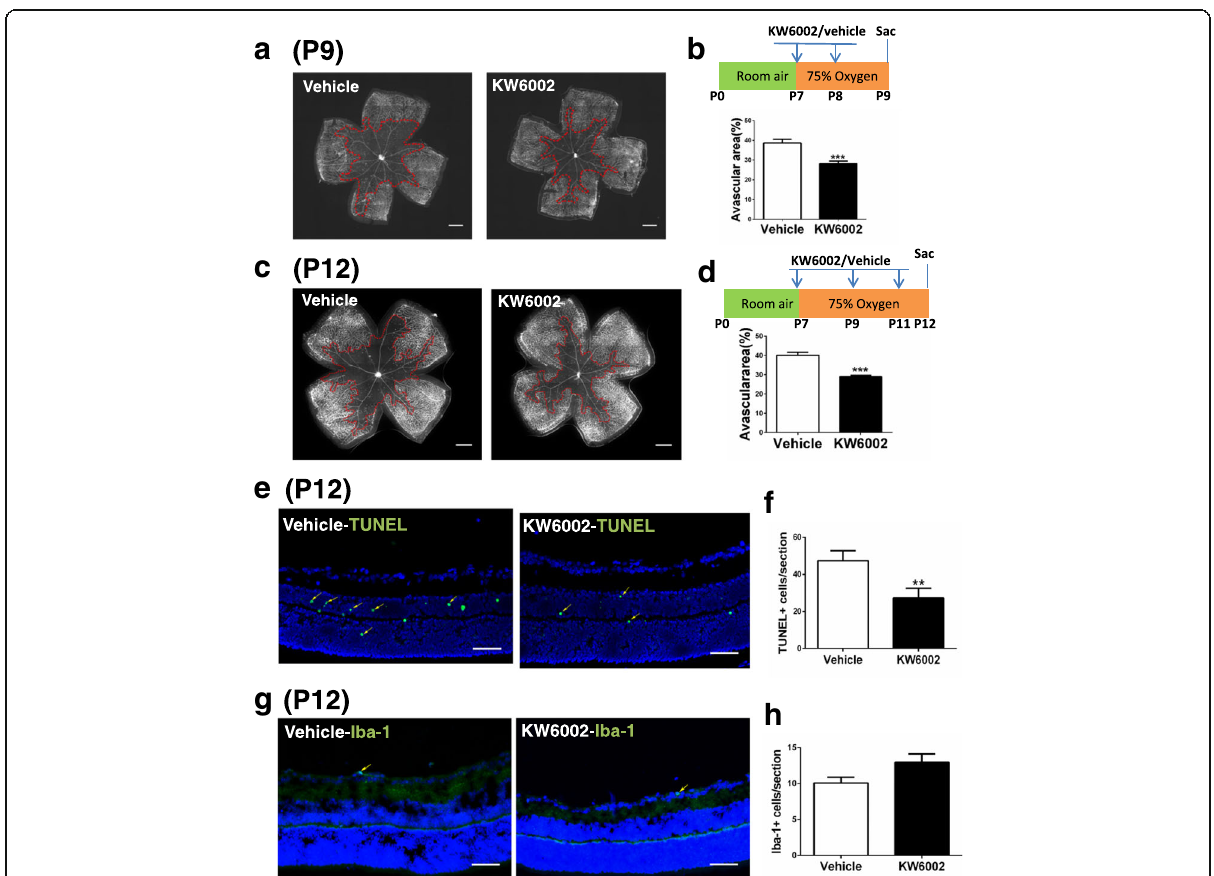
Fig. 5 KW6002 treatment reduced hyperoxia-induced retinal vascular regression at P9 and P12 and cellular apoptosis at P12, does not affect the activation of microglia. Whole-mount retinas ( a , c ) or retinal cross-section ( e , g ) from the vehicle-OIR and KW6002 groups were harvested on P9 ( a ) or P12 ( c , e , g ) and examined by immunostaining with isolectin B4, or histological analysis by TUNEL or Iba-1. Representative images show the avascular areas (indicated by red dotted line) at P9 ( a ) and P12 ( c ) (Scale bar: 500 μ m) and TUNEL + cells (indicated by yellow arrow) ( e ) or Iba-1 + cells (indicated by yellow arrow) ( g ) in retinal sections at P12 (Scale bar: 50 μ m). Areas of vaso-obliteration ( b , d ) and TUNEL + cells ( f ) or Iba-1+ cells ( h ) were quantified and analyzed ** P < 0.01, *** P < 0.001, Student ’ s t-test or Mann-Whitney U testn = 8